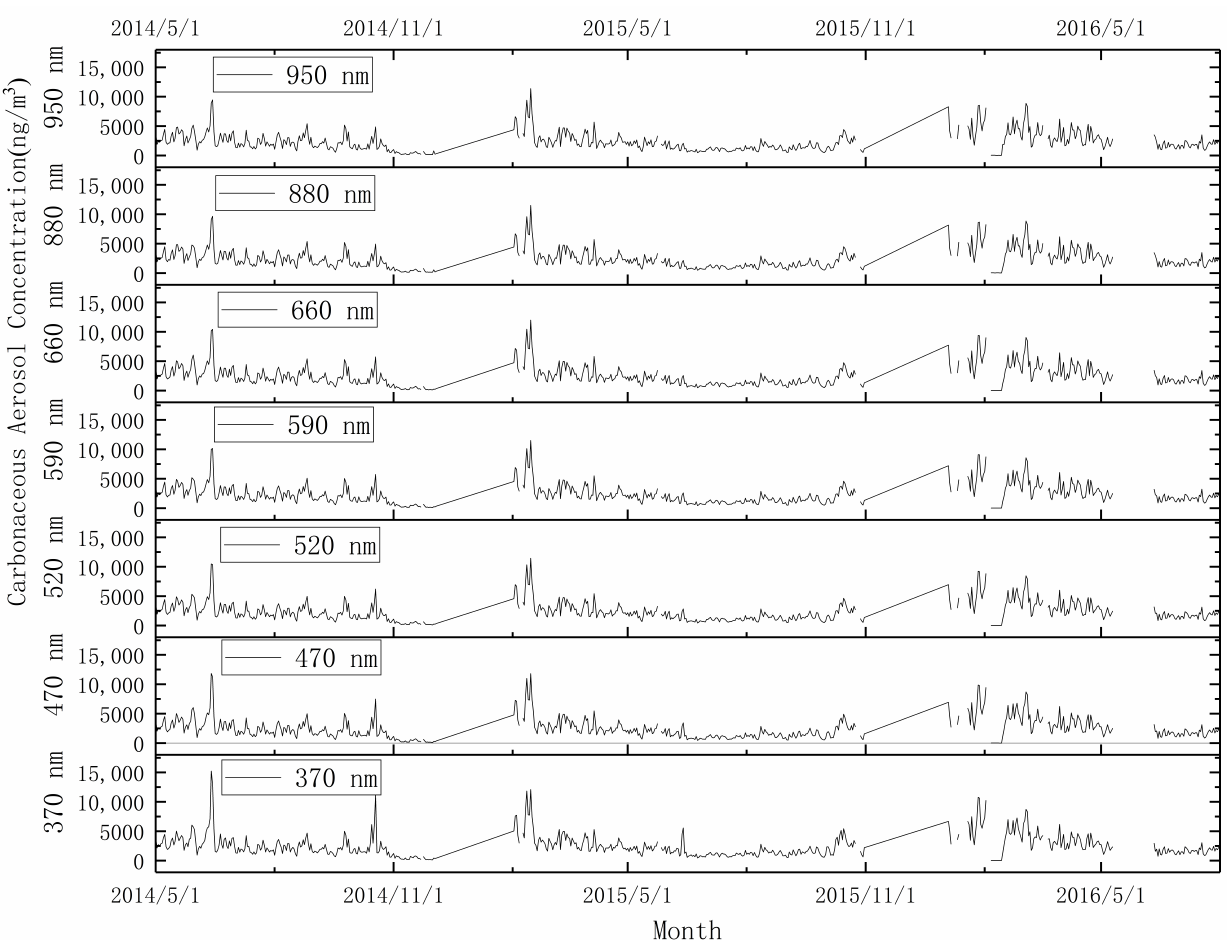
Figure 2. Daily variations in EBC in Xuzhou from May 2014 to July 2016. To ensure the representativeness of the daily average, only daily measurements with more than 16 hourly means are selected.